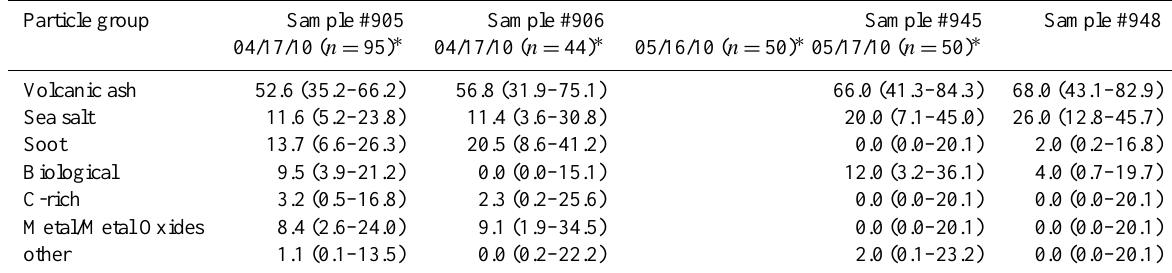
Table 2. Relative number abundances [%] and 95% confidence intervals (in parenthesis) of the different particle groups among IN collected from the atmosphere during the volcanic ash events on 17 April and 17 May